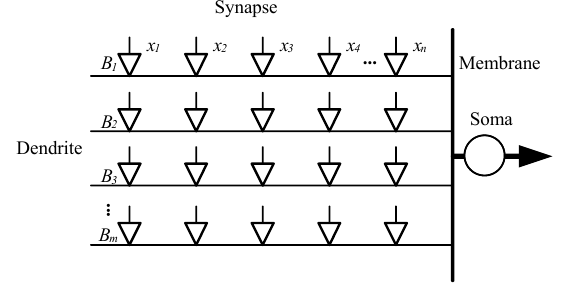
Figure 1. Structure of